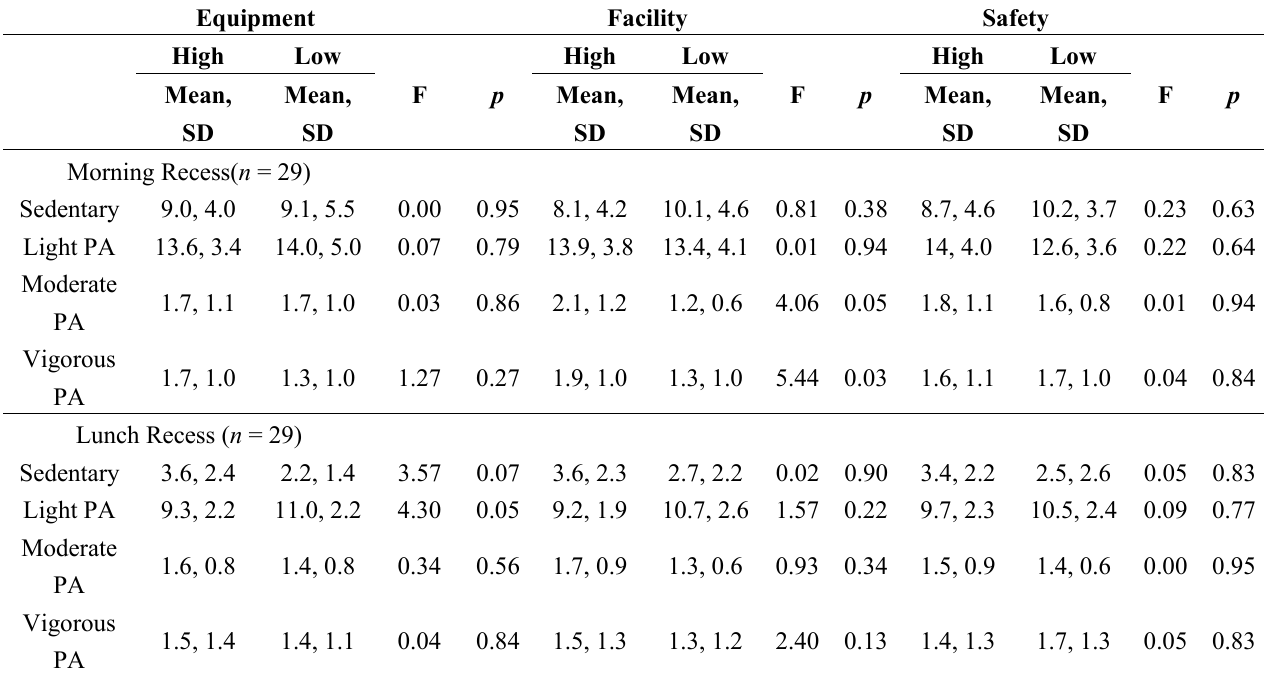
Table 3. Differences in recess physical activity according to perception of school environment